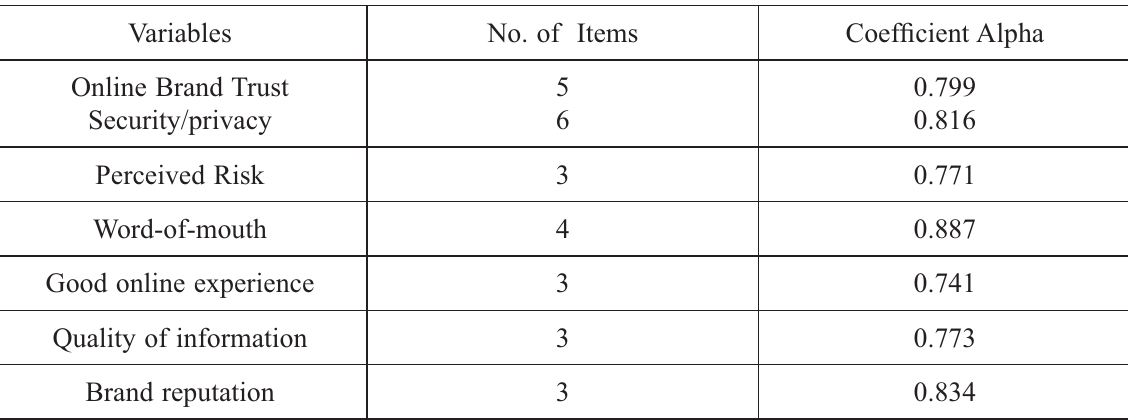
Table 2. Reliability